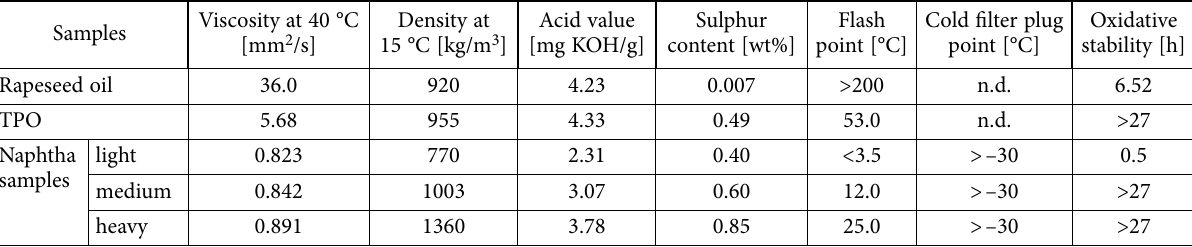
Table 1. Characteristics of rapeseed oil, TPO and naphtha fractions Samples